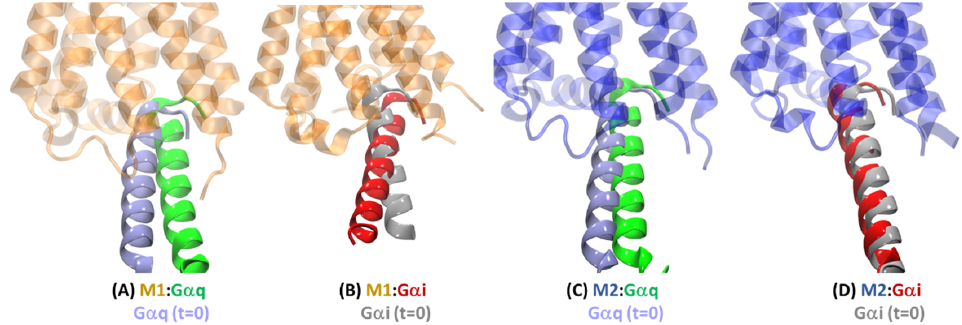
Figure 6. Comparison of the cognate complexes with the non-cognate complexes. ( A ) Overlay of M1:G α q (orange / green) and M1:G α i (light orange / red) complexes from the average MD structures; ( B ) Overlay of M2:G α q (blue / green) and M2:G α i (light blue / red) complexes from the average MD structures.